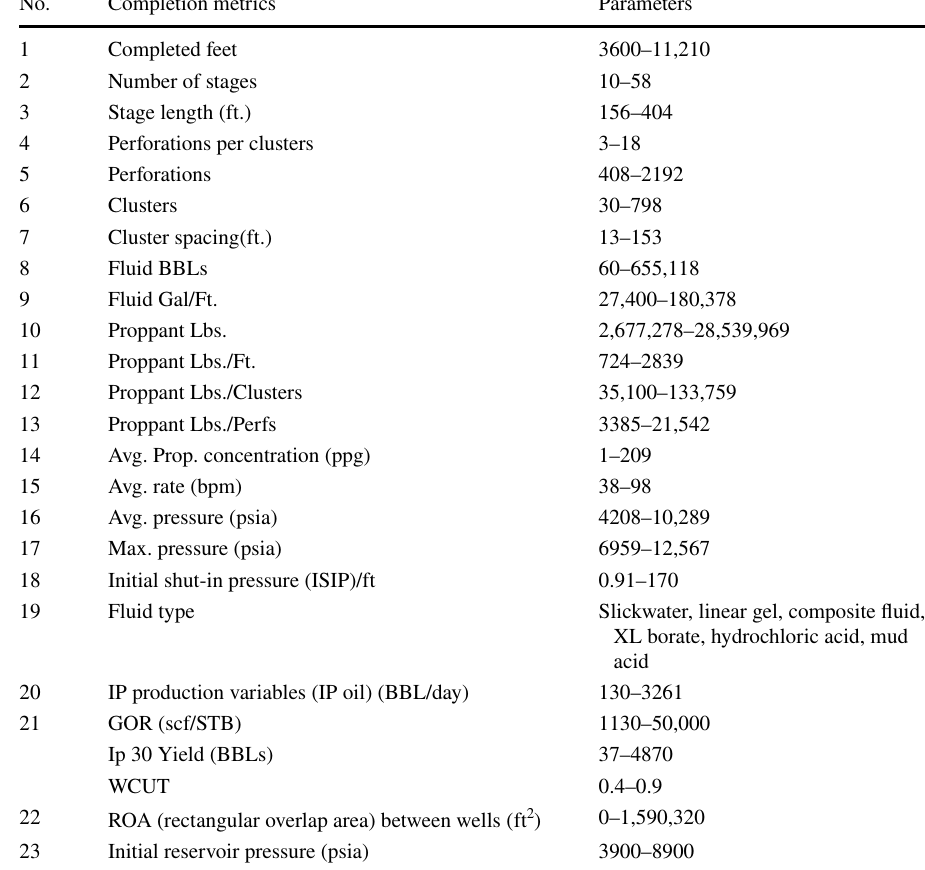
Table 2 Range of completion parameters used to develop the